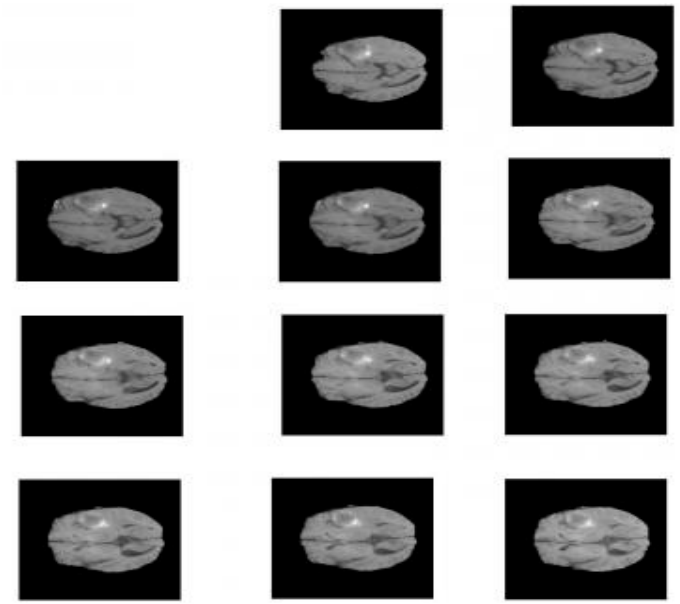
Figure 3. Sample images from BraTS.